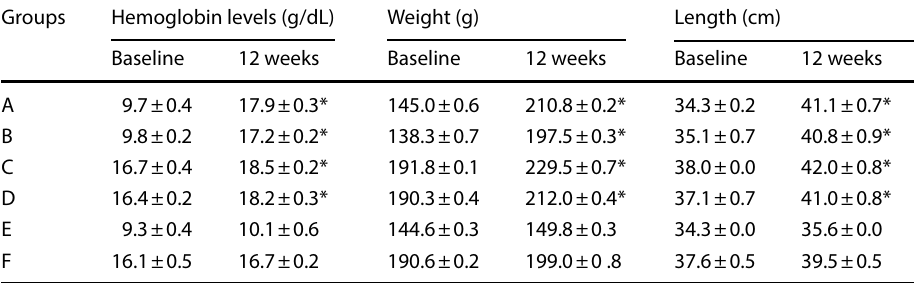
A, anemic rats treated with 360 mg/kg quinoa flour; B, anemic rats treated with 360 mg/kg kanihua flour; C, healthy rats treated with 360 mg/kg quinoa flour; D, healthy rats treated with 360 mg/kg kani‑ hua flour; E, Anemic rats + vitamin C; F, Healthy rats + vitamin C. Each point represents the mean ± SEM of three rats, * p ≤